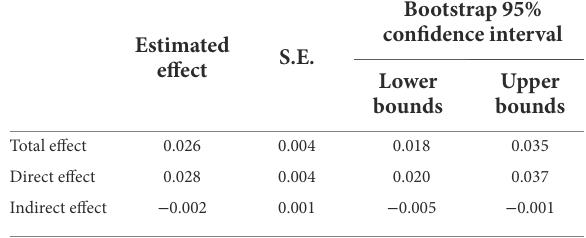
TABLE 3 Bootsrapping mediating effect analysis.